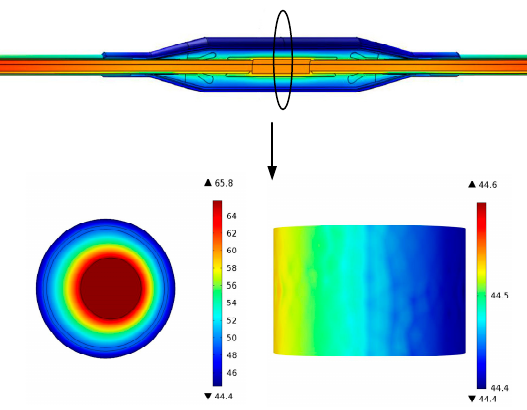
Figure 6. Temperature distribution when D = 3 mm.